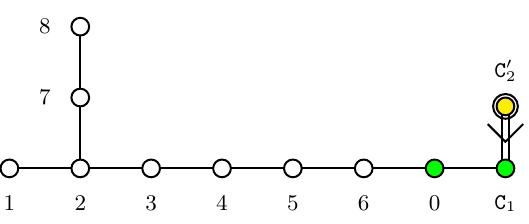
Figure 3 . Generalized Dynkin diagram for d = 2 theories with enhancements to algebras with C n factor. It is obtained from the GDD in figure 2 by replacing the node C 2 with C 0 in (3.11). Yellow coloring means that the state has nontrivial momentum number and/or winding along directions 1 and 2.